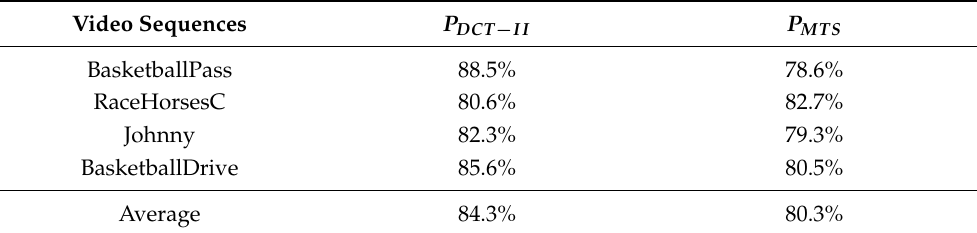
its neighboring CUs.